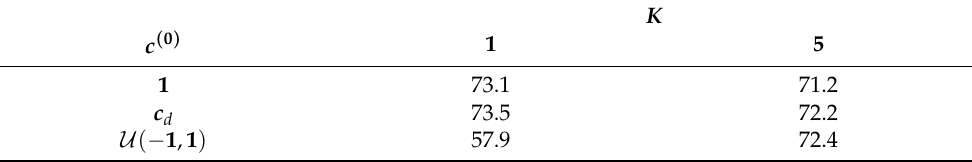
Table 3. Test accuracy (%) on the MR task for different default context strategies